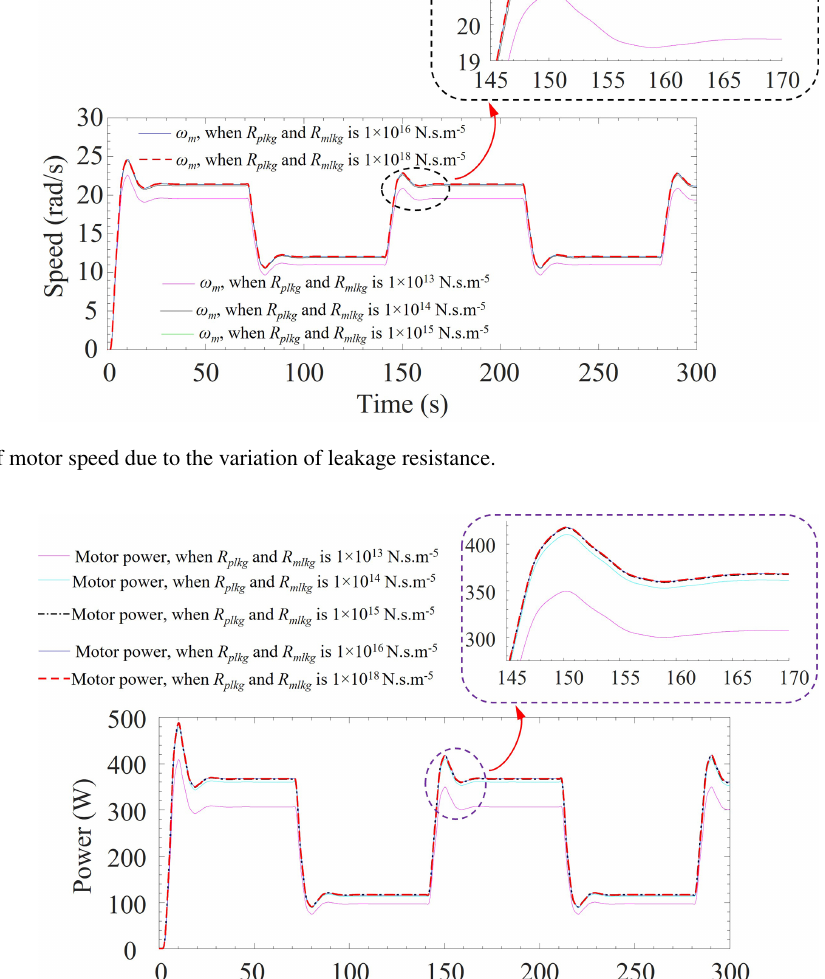
shaft to the electric generator in a wind turbine